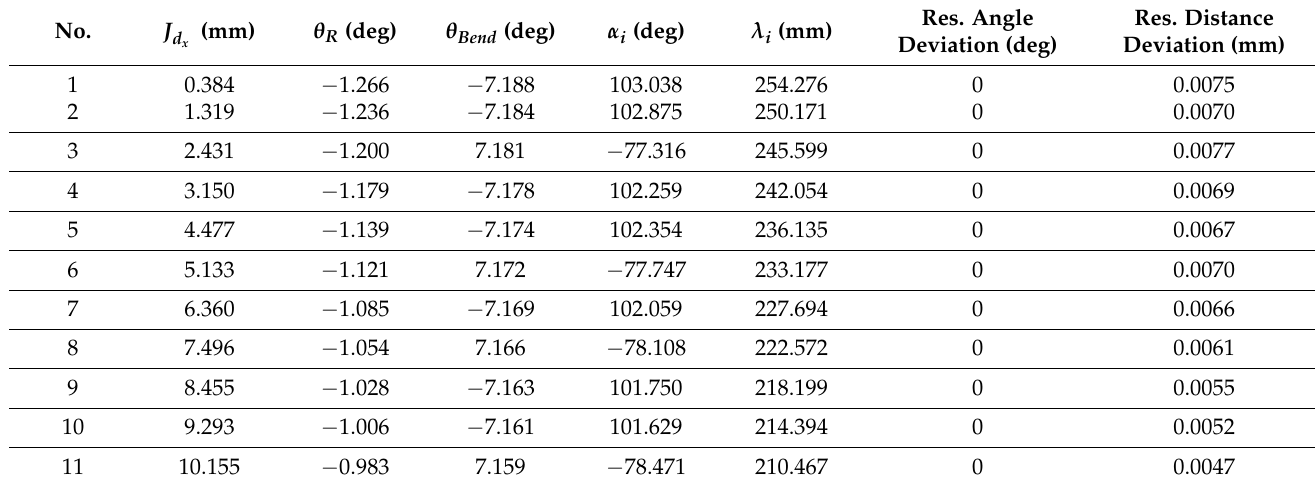
Table 2. Series of feasible calculation solutions for adjustable pipe.